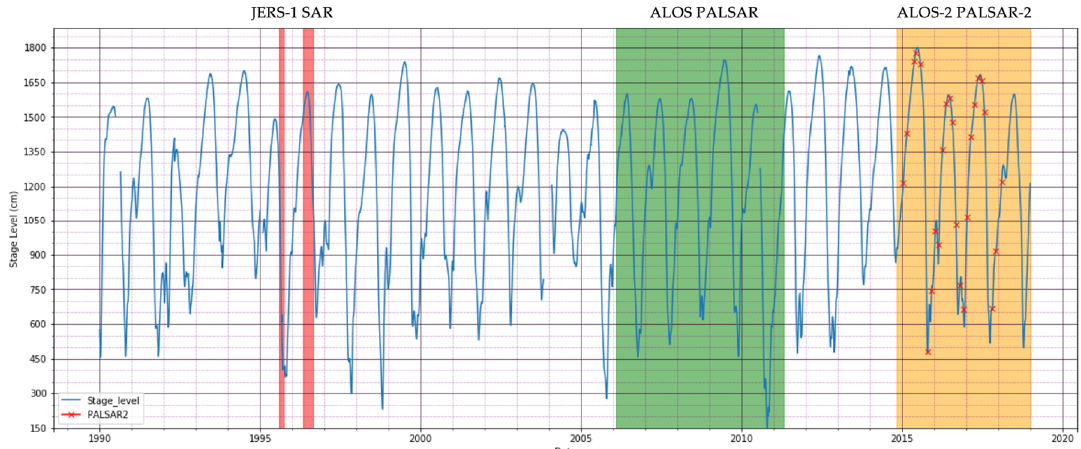
Figure 8. River stages 1990–2018. Station o-385, Itapeua, Rio Solimões (S4.058°/W63.028°). Red, green and yellow fields indicate JERS-1 SAR, ALOS-PALSAR and ALOS-2 PALSAR-2 acquisition periods, respectively. Red crosses indicate PALSAR-2 acquisition dates and illustrate how well the annual maximum and minimum inundation levels around the gauge station were captured in the PALSAR-2 data.